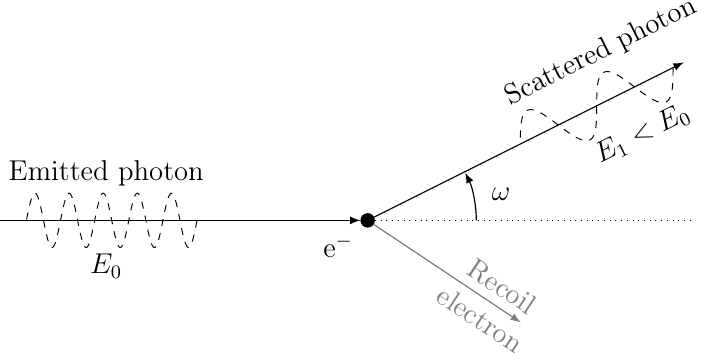
Figure 1. Geometry of the Compton effect: the incident photon energy E 0 yields a part of its energy to an electron and is scattered with an angle ω